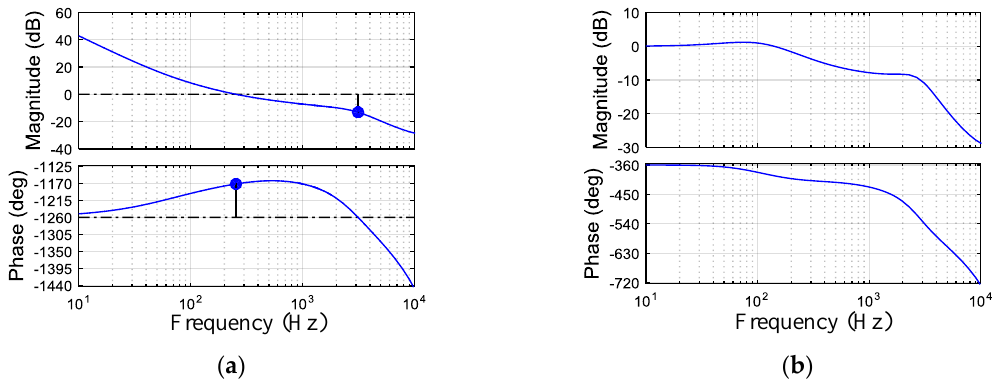
Figure 18. Frequency characteristics of the voltage loop with discrete control: ( a ) Open-loop Bode diagrams; ( b ) Close-loop Bode diagrams.